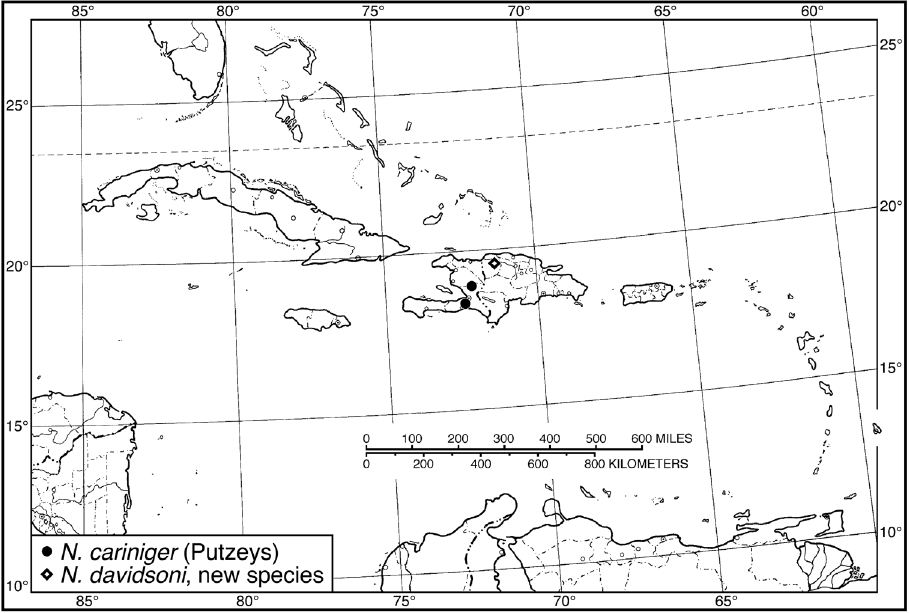
Figure 13. Map of West Indies showing known localities for species of Neodiachipteryx